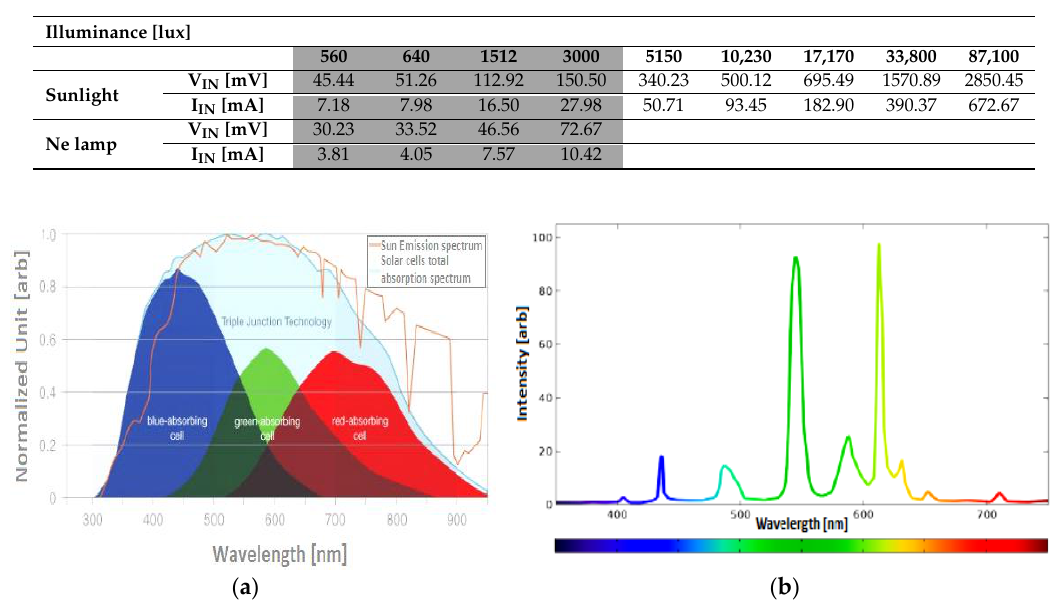
Table 2. Current (I IN ) and voltage (V IN ) values provided by the series of two Size 2 solar cells to LTC3108-based conditioning section for different light sources (sunlight and Ne lamp) and illuminance values.